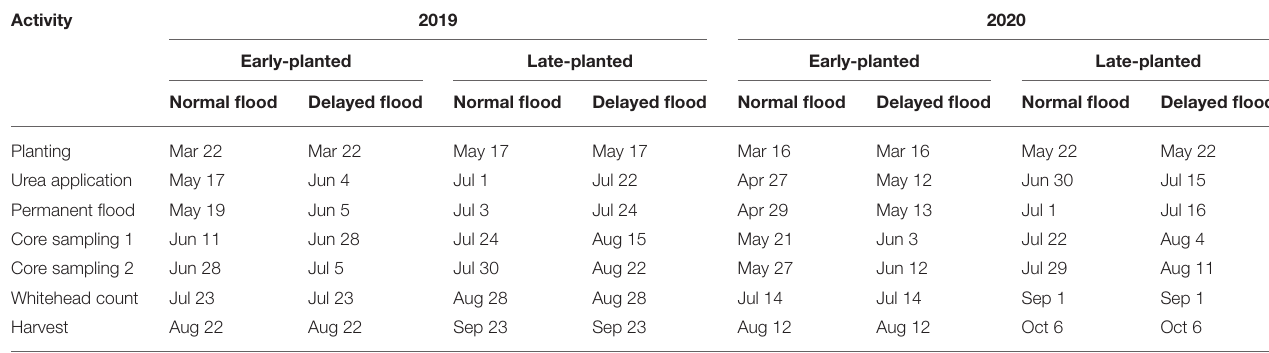
TABLE 1 | Field activities and corresponding dates.